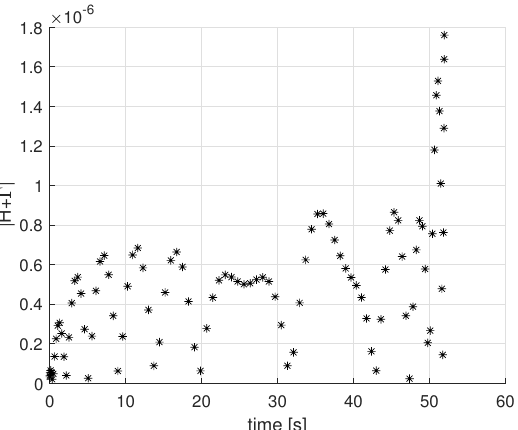
Figure 8. Hamiltonian loss for the constrained intercept problem with penalty Γ = 1 ( N = 100 and L =